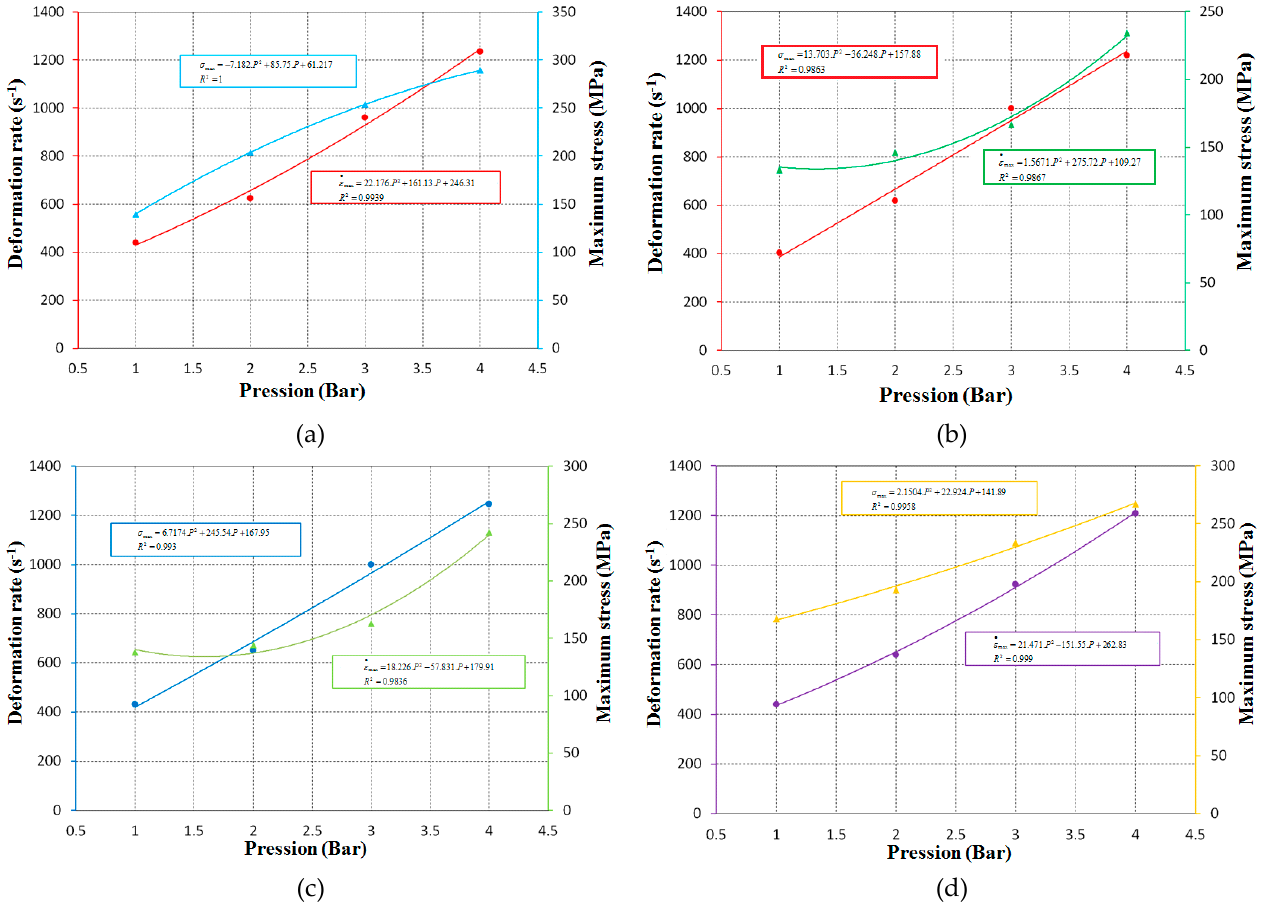
Figure 9. Variation of maximum stress/strain rate in function of aging time. ( a ) t = 0 h. ( b ) t = 216 h. ( c ) t = 648 h. ( d ) t = 864